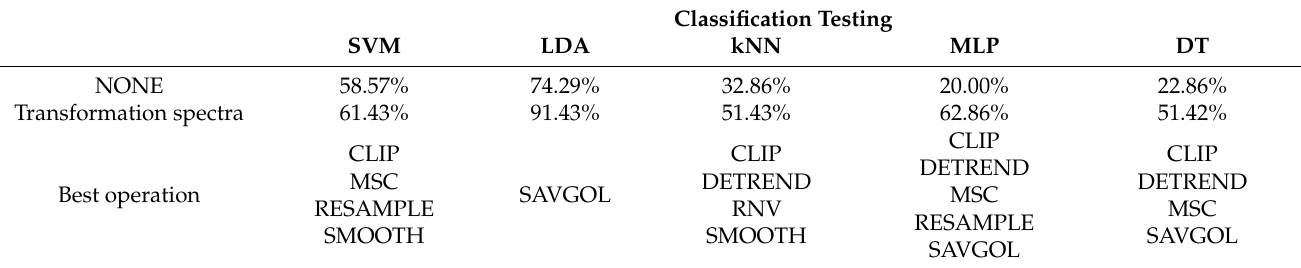
Table 5. Comparison results of direct approach classification.